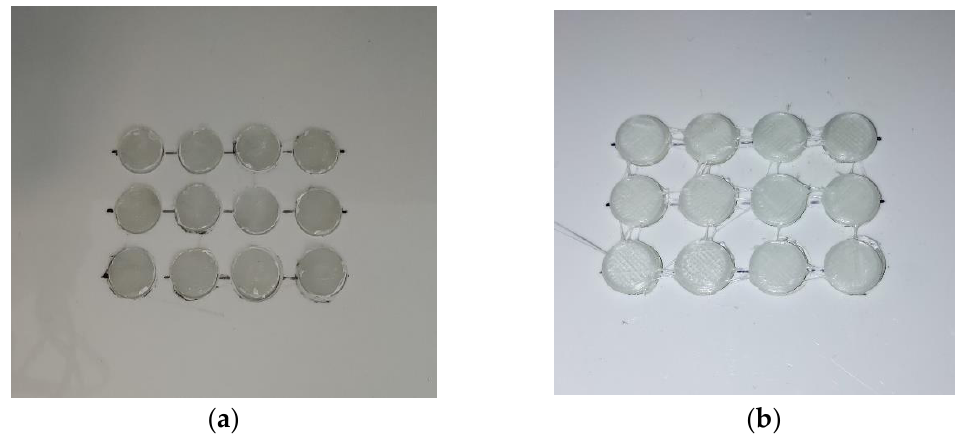
Figure 9. The overprinting process: ( a ) from injection-molded tablet substrates installed in template; ( b ) to overprinted tablets completed.